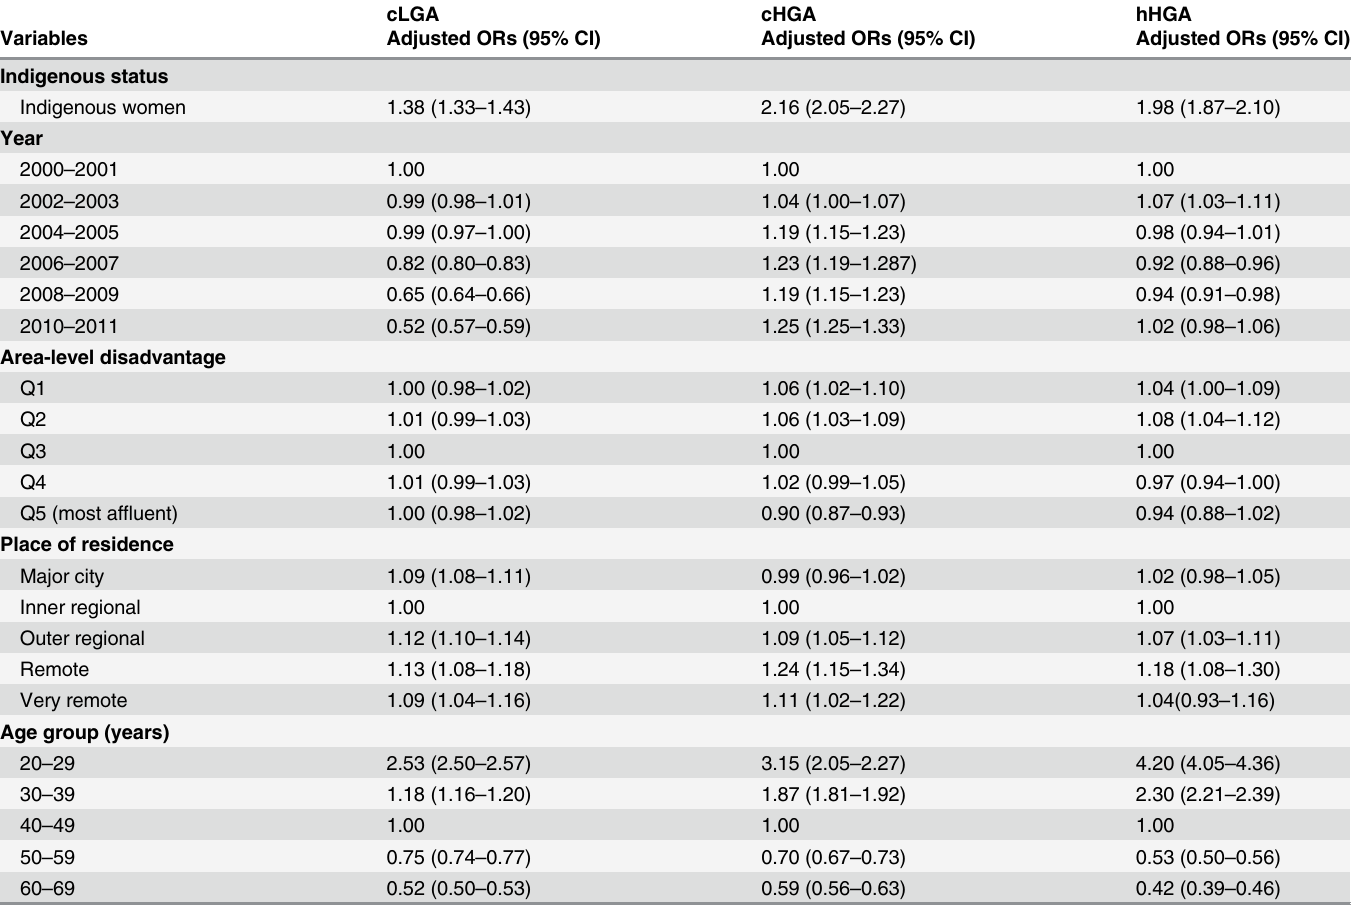
Table 3. Association of Indigenous status, calendar period, place of residence, area-level disadvantage and age with risk of cytology detected low-grade abnormalities and cytological and histological high-grade abnormalities including cervical